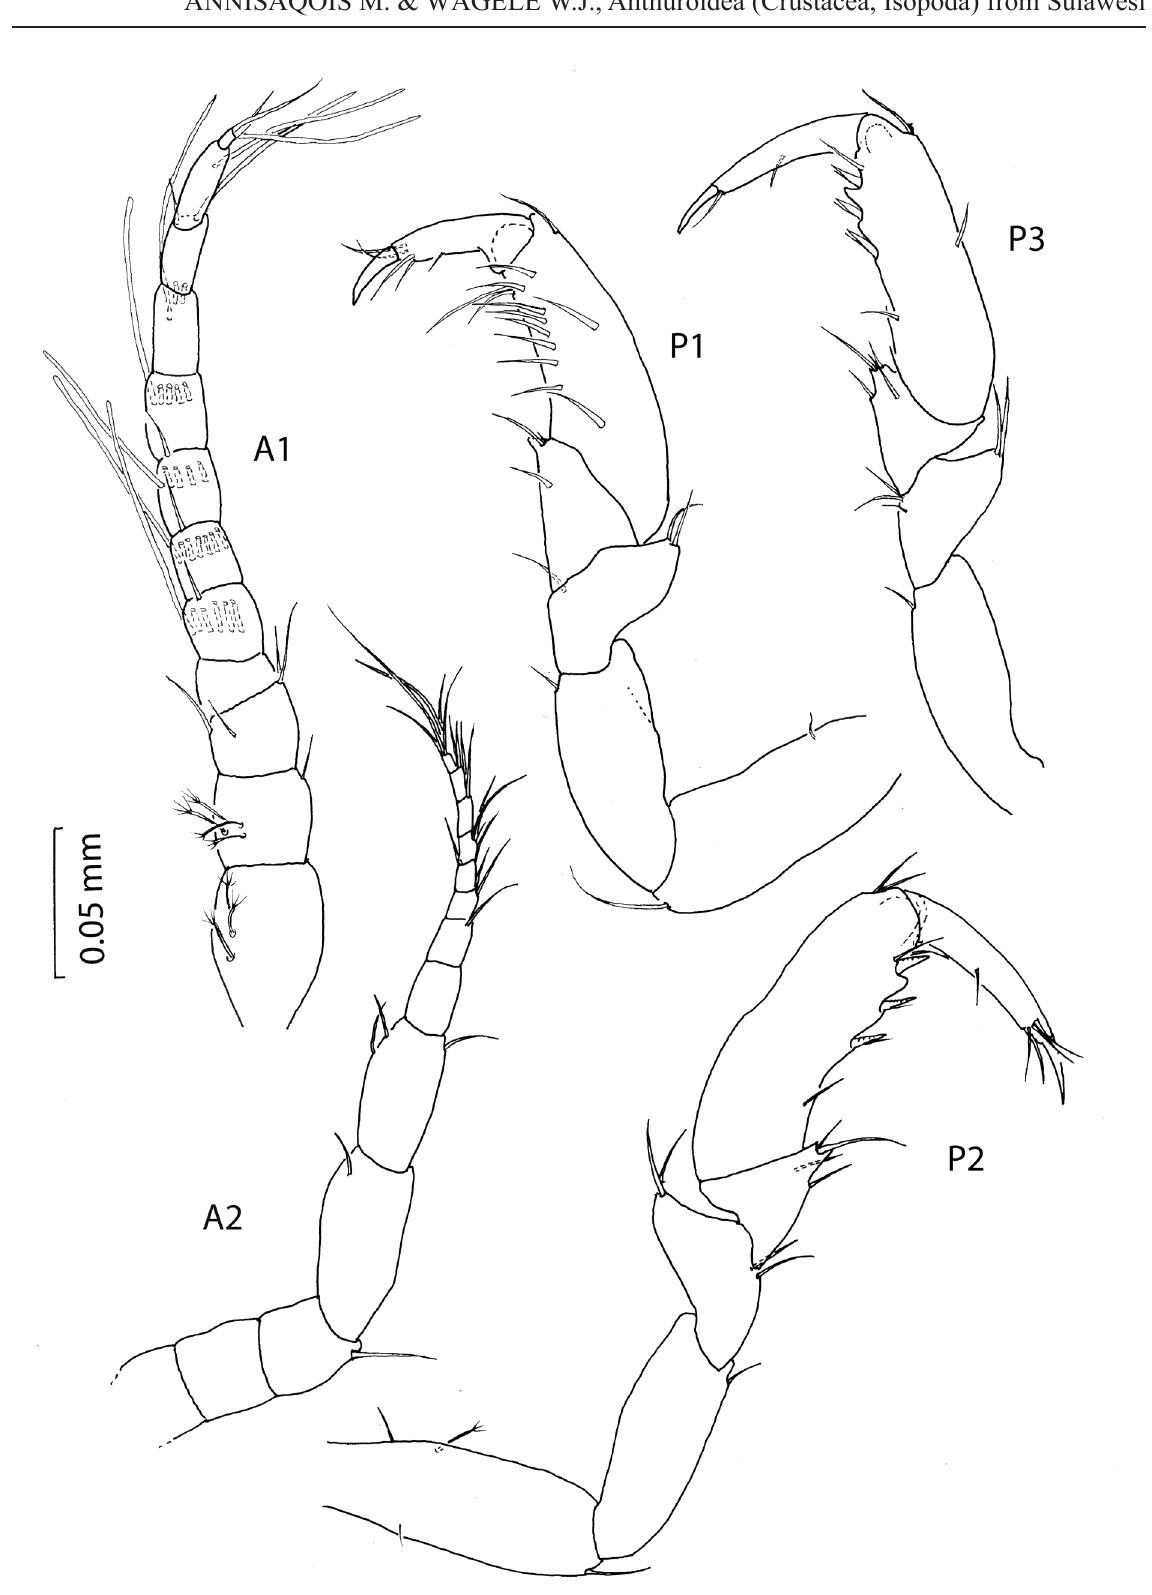
Fig. 3. Hyssura reptan sp. nov., ♂, holotype (MZB Iso 099). Abbreviations: A1 = antenna 1; A2 = antenna 2; P1–P3 = pereopods